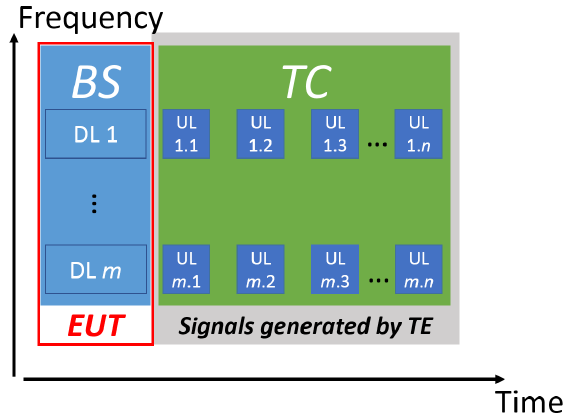
Figure 11. Sketch of the DL and UL signals for node testing. The parts of the hardware setup that generate the corresponding signals are denoted in italics.